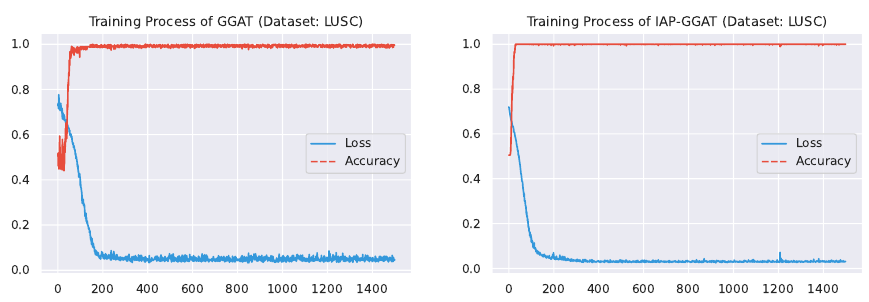
Figure 11. Training process of GGAT and IAP-GGAT on LUSC